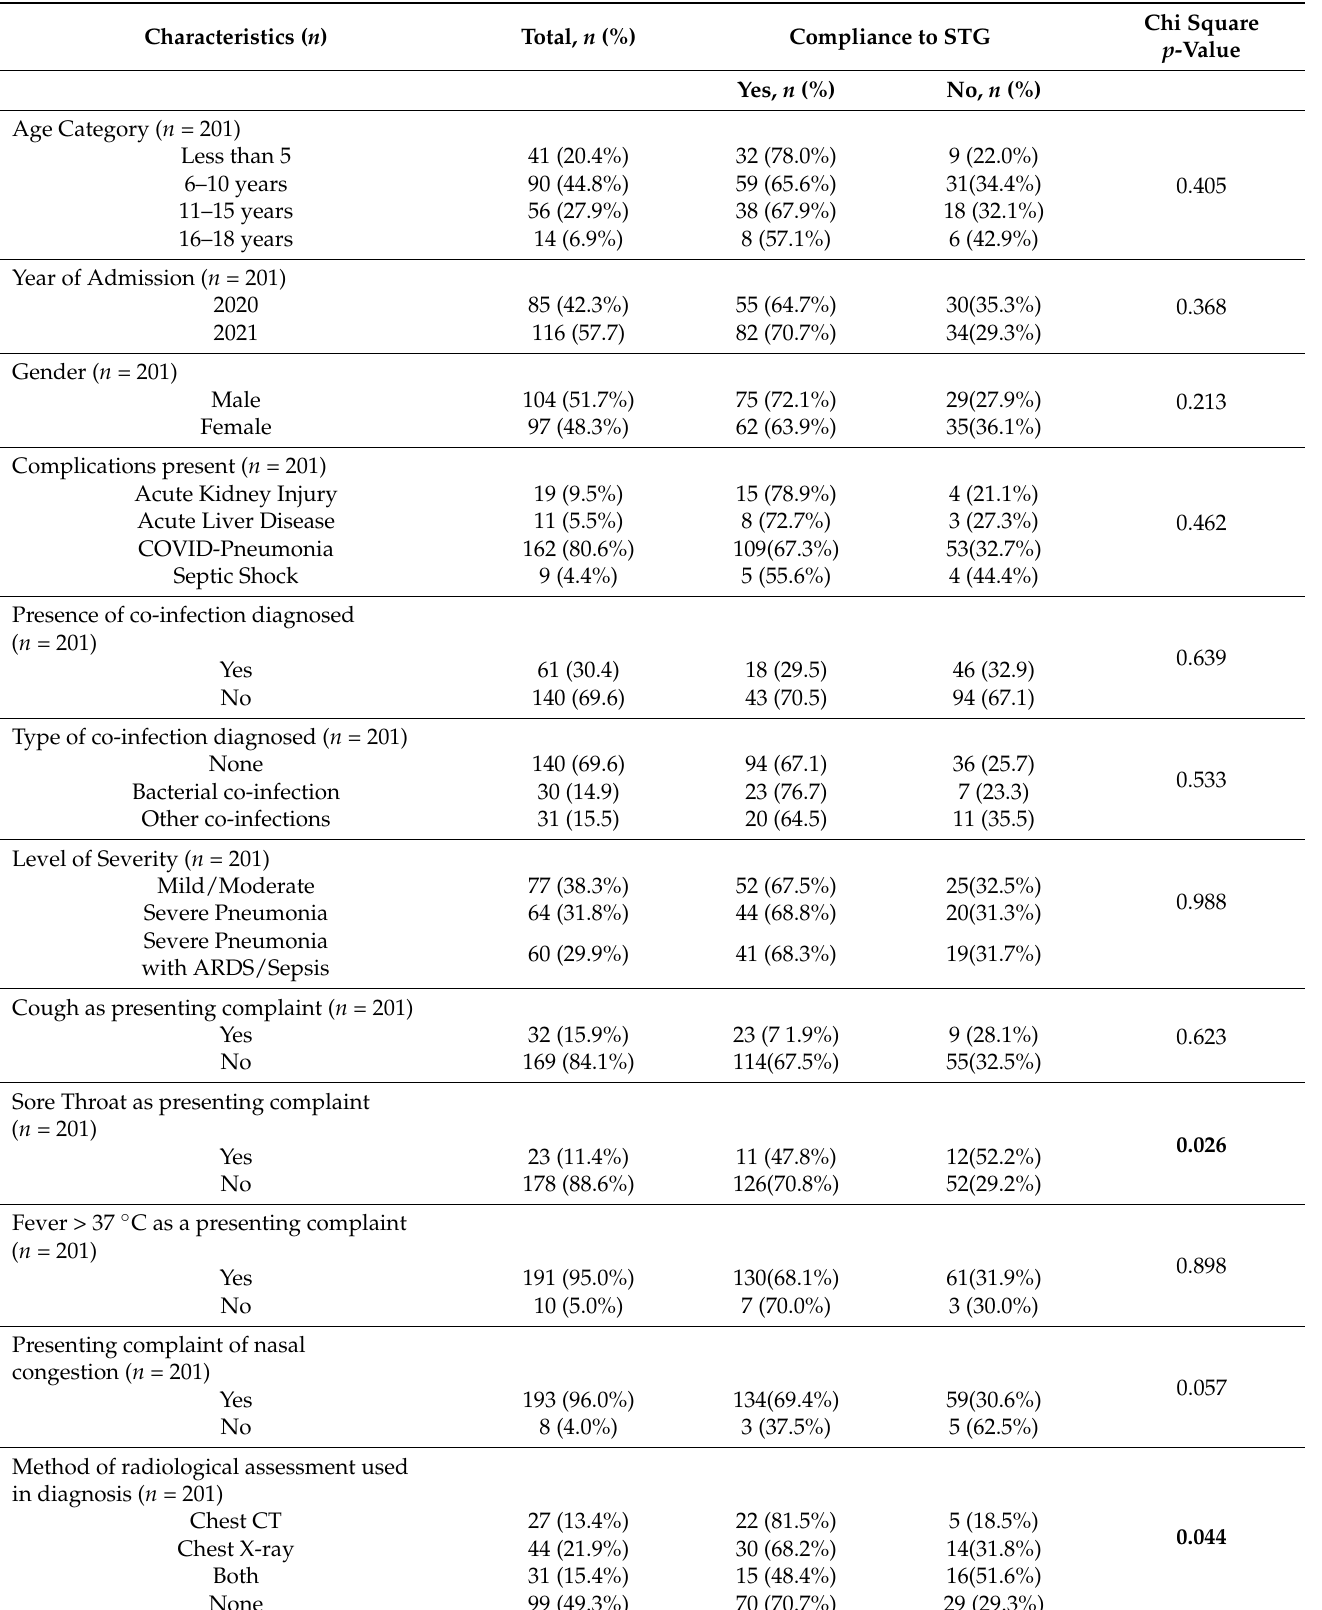
Table 1. Association between compliance to the COVID-19 Standard Treatment Guidelines (STG) and patients’